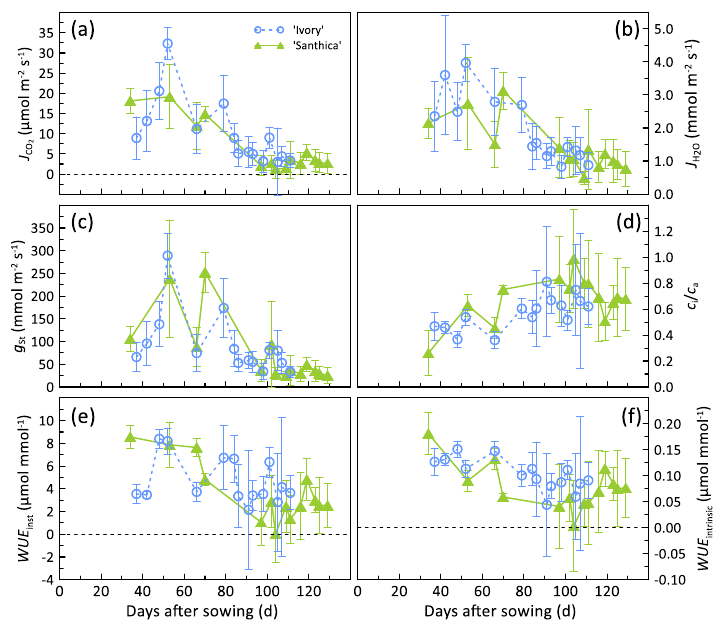
Figure 4. ( a ) Rates of net CO 2 exchange ( J CO2 ), ( b ) transpiration ( J H2O ), ( c ) stomatal conductance for water vapor transfer ( g st ), ( d ) ratio of internal to ambient CO 2 mole fraction ( c i / c a ), ( e ) instantaneous ( WUE inst ) and ( f ) intrinsic ( WUE intrinsic ) water use efficiencies of ‘Ivory’ (open circles) and ‘Santhica 27’ (closed triangles) plants during the course of the growing season.